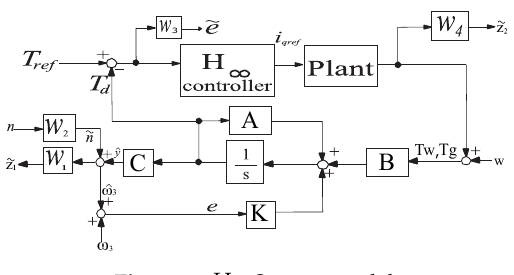
Figure 5. H ∞ System